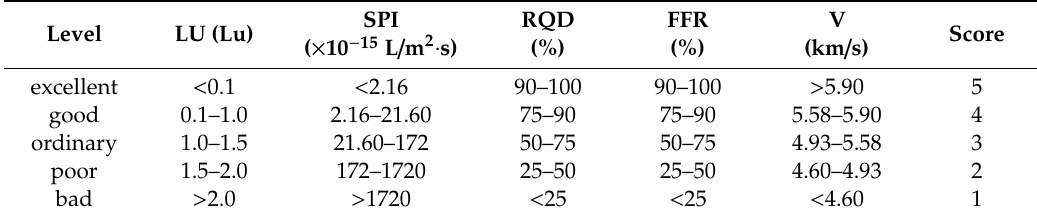
Table 1. The classification criteria of grouting e ffi ciency evaluation